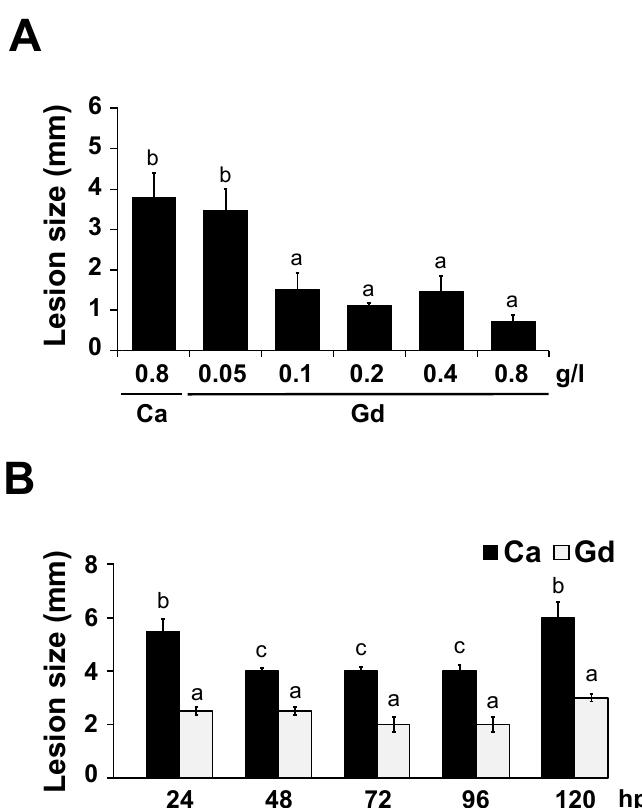
Figure 3. Gd-induced protection against B. cinerea is dose-dependent and long-lasting. ( A ) Four-week-old A. thaliana plants were pre-treated for 24 h (24 hpt) with the indicated Gd concentration or 0.8 g/L of Ca. After this, 3 μ L droplets containing a B. cinerea spore suspension (5 × 10 4 spores mL − 1 ) were applied and infection symptoms were evaluated at 72 hpi by measuring lesion size. ( B ) Four-week-old A. thaliana plants were sprayed until saturation with 0.2 g/L of Ca or Gd for 24, 48, 72, 96, or 120 (hpt); after these times, 3 μ L droplets containing B. cinerea spore suspension (5 × 10 4 spores mL − 1 ) were applied and infection symptoms were evaluated at 72 hpi by measuring lesion size. Bars represent mean values ( ± SD) of three independent experiments ( n = 30 for each experiment). Different letters above each bar represent statistically significant differences according to the Scott–Knott test ( p < 0.05).